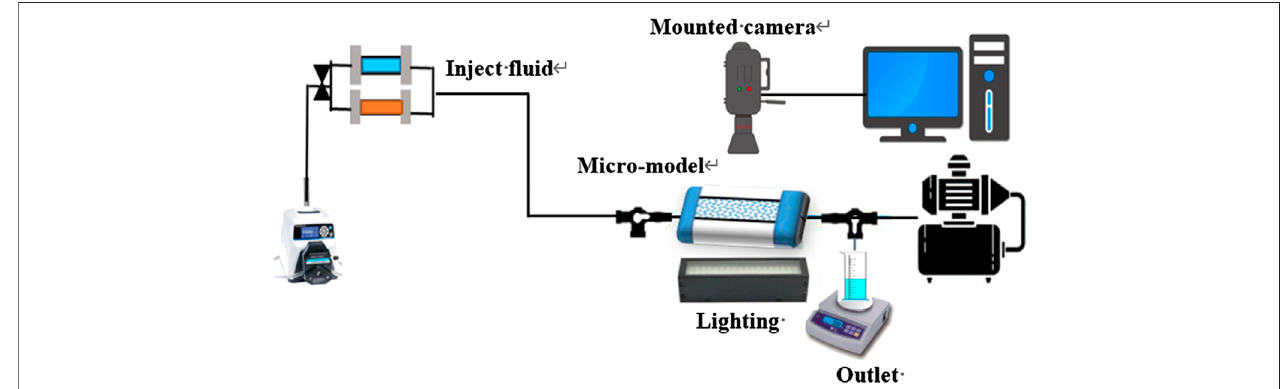
FIGURE 2 | Microscopic visual model displacement experimental device.